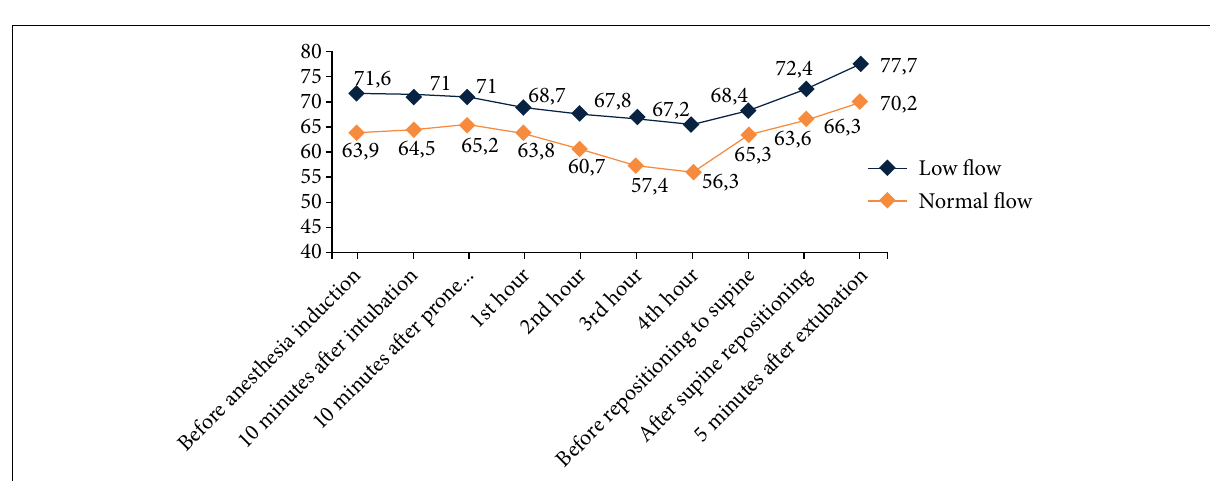
Figure 2 – Left-sided cerebral oxygen saturation measurements during study time-points.